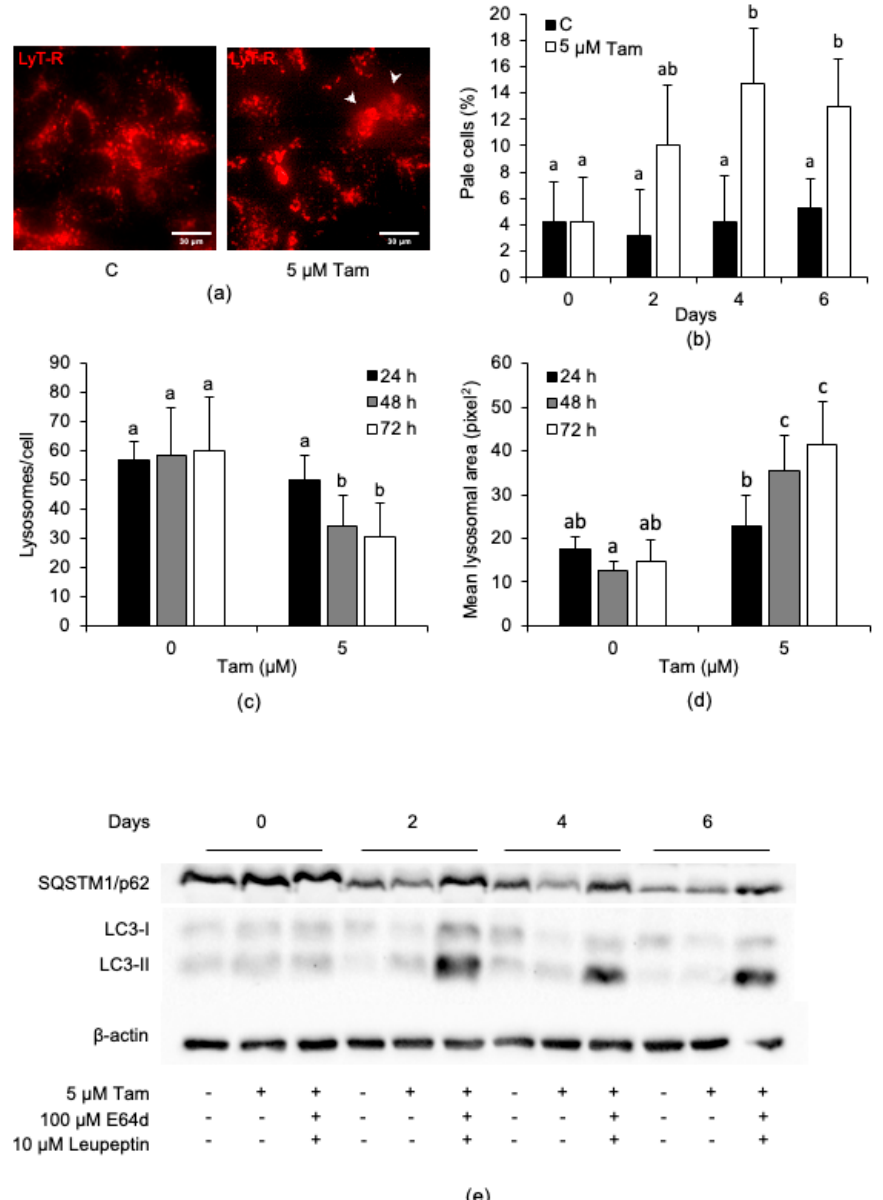
Figure 2. Tam (5 µM) triggers lysosomal membrane permeabilization (LMP) and autophagic flux in MCF7 cells. ( a ) LMP triggered in MCF7 cells (arrows) after 6 days of Tam treatment. ( b ) Number of pale cells, counted every second day of Tam treatment. ( c ) Effect of Tam on the number of lysosomes/cell and ( d ) on the mean lysosomal area. For each sample, at least 25 single cells were used for measurements. ( e ) Relative amount of the autophagy substrate SQSTM/p62 and of LC3-I/II analyzed for up to 6 days of continuous Tam treatment; refer to Figure S7 for the original blots. The pictures in panel ( a , e ) are representative of three independent experiments. Data and statistical analysis are as in Figure 1.